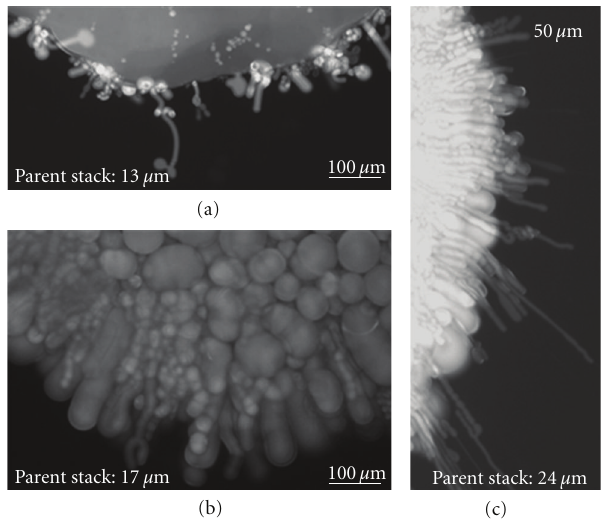
Figure 2: Comparison of average diameter of myelin figures protruded from parent lipid plaques with di ff erent thicknesses shows no exact correlation between the thicknesses of parent stack and the diameter of myelin